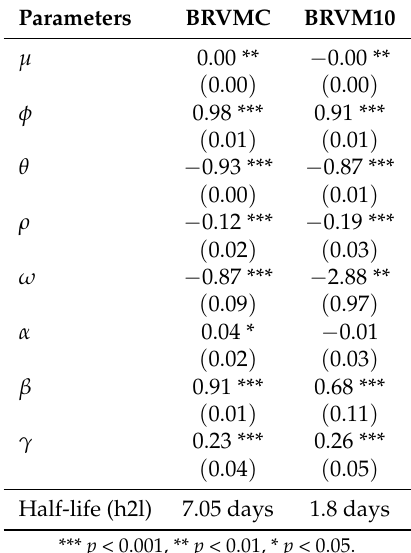
Table 4. Estimated parameters for the models and half-life.